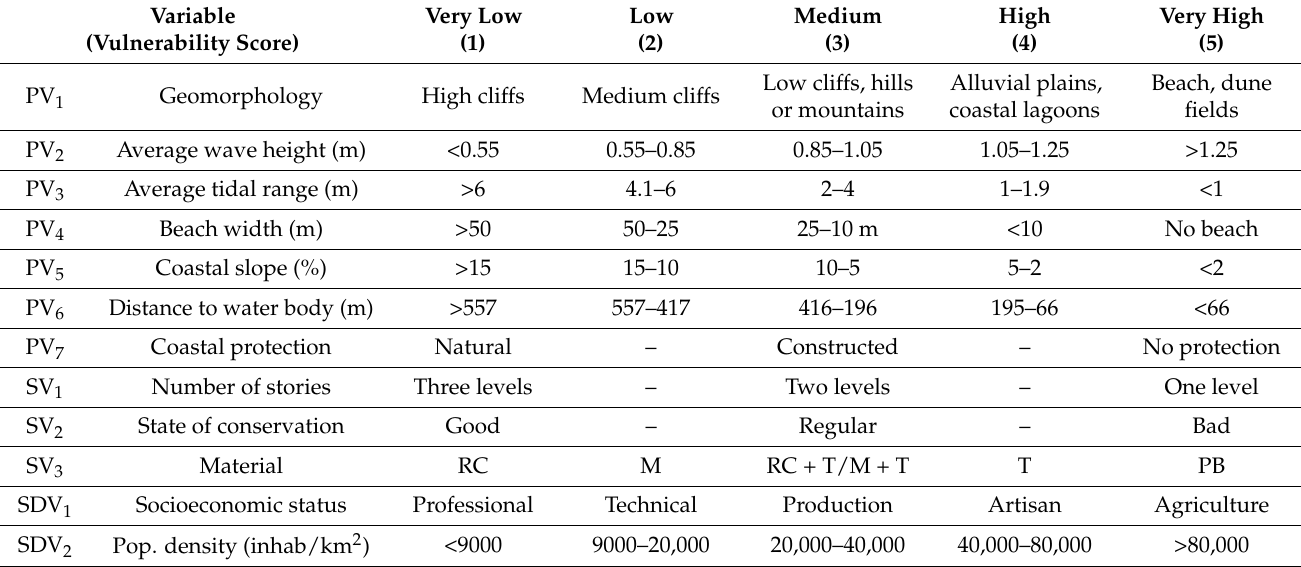
Table 9. Chart of vulnerability classification.